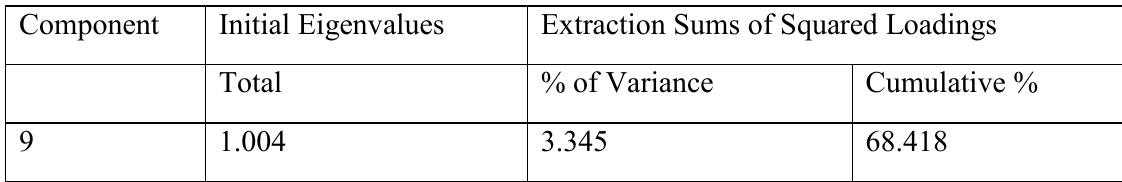
Table 1.55: Variance explained for Transformative Resilience